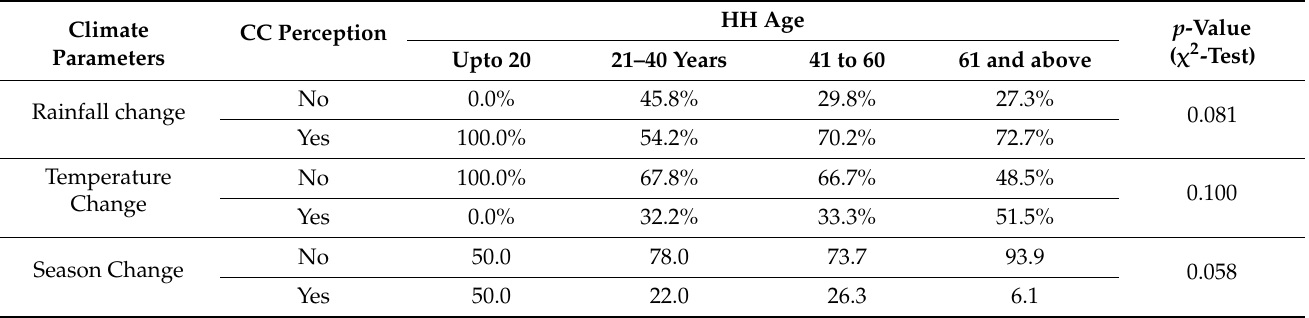
Table 5. Climate change perception and age of respondents in the study